Question: Provide a one-line summary of what is displayed.
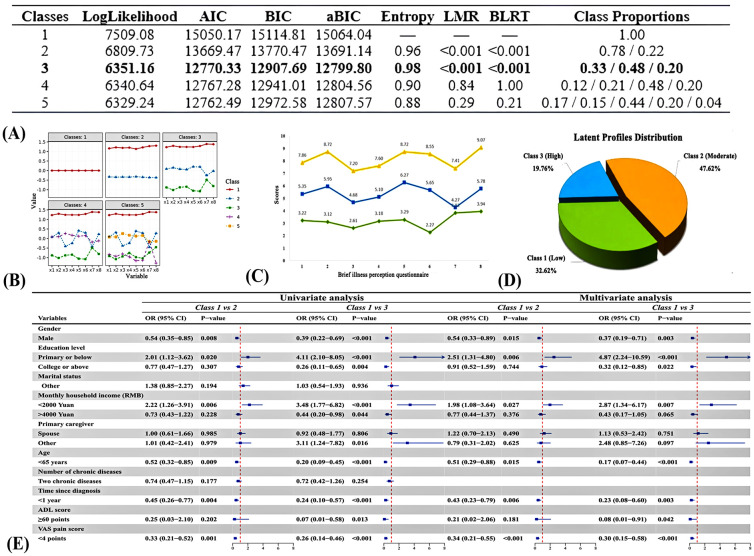
Answer: (A) Fit indices for the latent profile models. (B) Curves illustrating model fit. (C) The three final latent classes were identified. (D) Distribution of the three latent classes. (E) Univariate and multivariate logistic regression analyses based on LPA.